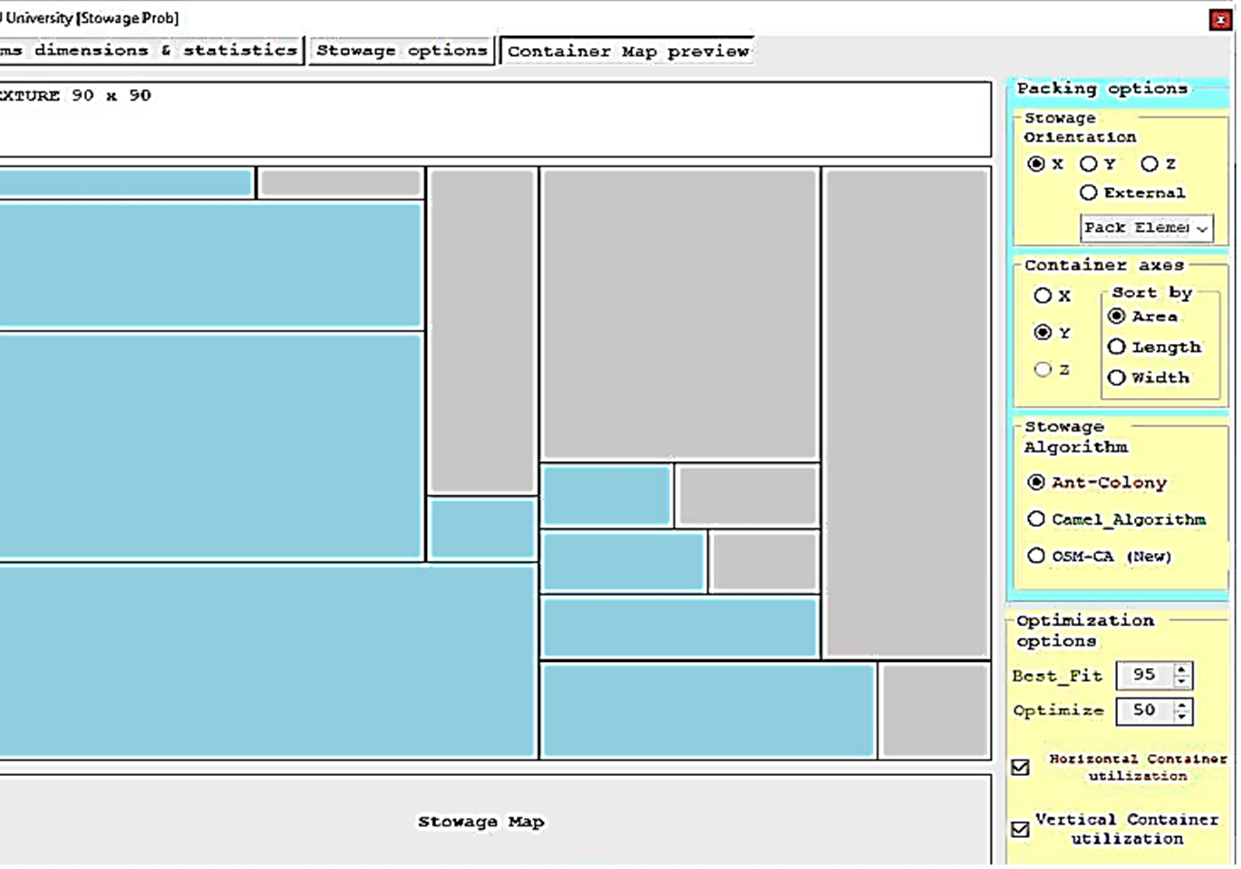
Figure A4. The stowage map for nine objects by the ant-colony algorithm optimization for first station on the distribution path.